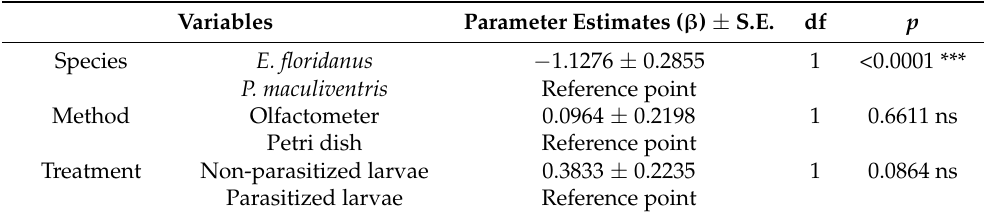
Table 6. Maximum likelihood estimates for olfactometer and Petri dish methods for prey preference study on fall armyworm 1